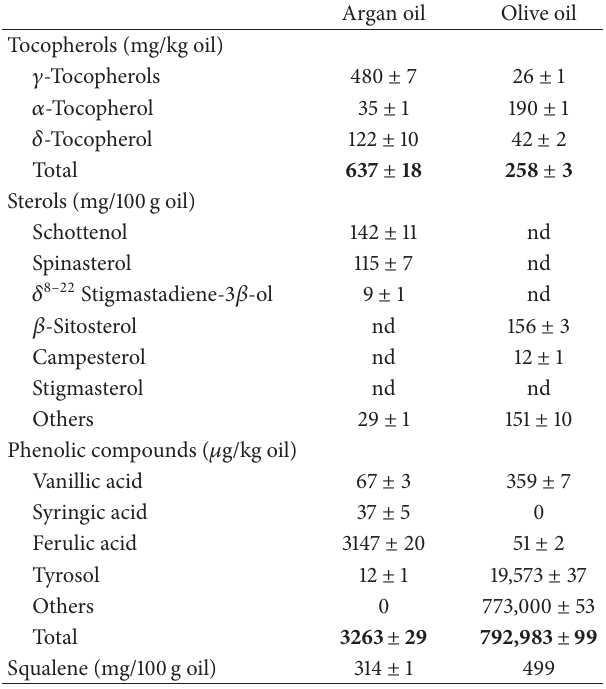
Table 1: Chemical composition of argan oil and olive oil [2]. Argan